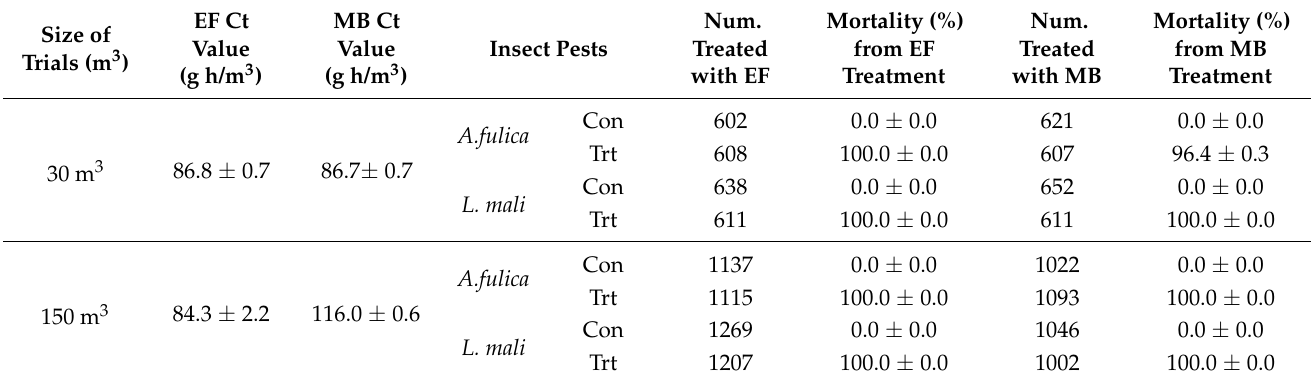
Table 2. Concentration × time (Ct) and efficacy of ethyl formate (EF) and methyl bromide (MB) fumigation on Achatina fulica juveniles and the third- and fourth-instar larvae of Lycoriella mali in scale-up trials (30 and 150 m 3 ). In both size trials, EF was treated at 35 g/m 3 for 4 h at 15 ± 1 ◦ C. For 30 m 3 MB trials, MB was treated at 48 g/m 3 for 2 h at 15 ± 1 ◦ C. For 150 m 3 MB trials, MB was treated at 48 g/m 3 for 3 h at 15 ± 1 ◦ C. Con and Trt mean control and